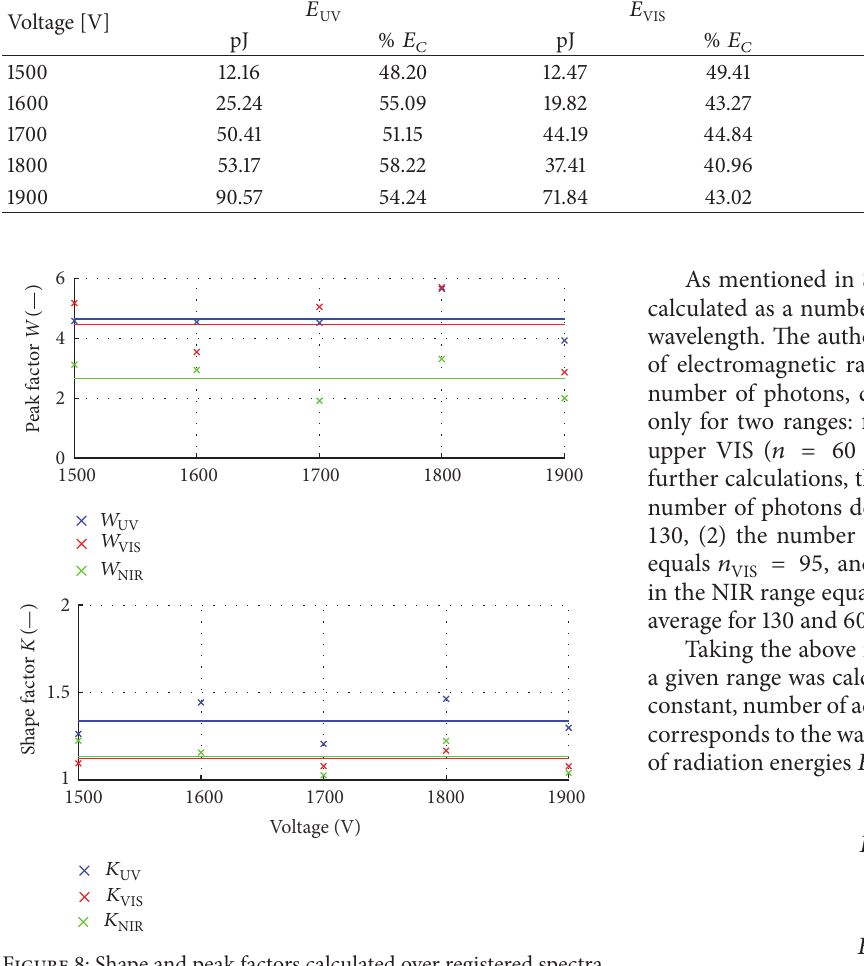
Figure 8: Shape and peak factors calculated over registered spectra at the considered